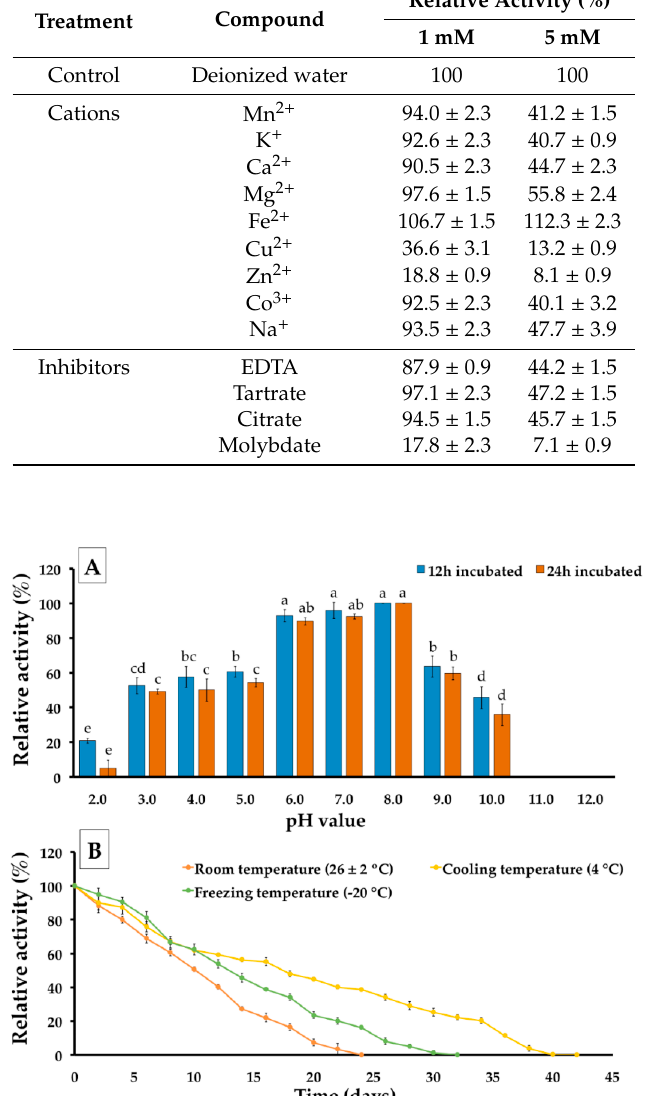
Figure 7. The stability of P. adiposa activity in different conditions. ( A ) pH stability during incubation for 12 and 24 h at 4 °C. ( B ) thermal stability. The results are means ± SD. Different letters above each bar in the same parameter indicate the significant difference ( p < 0.05).